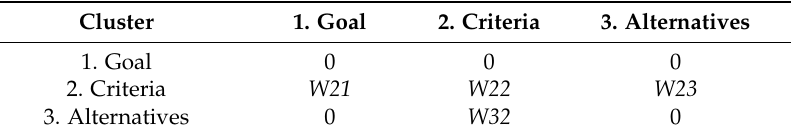
Table 7. Supermatrix form for this case study (W